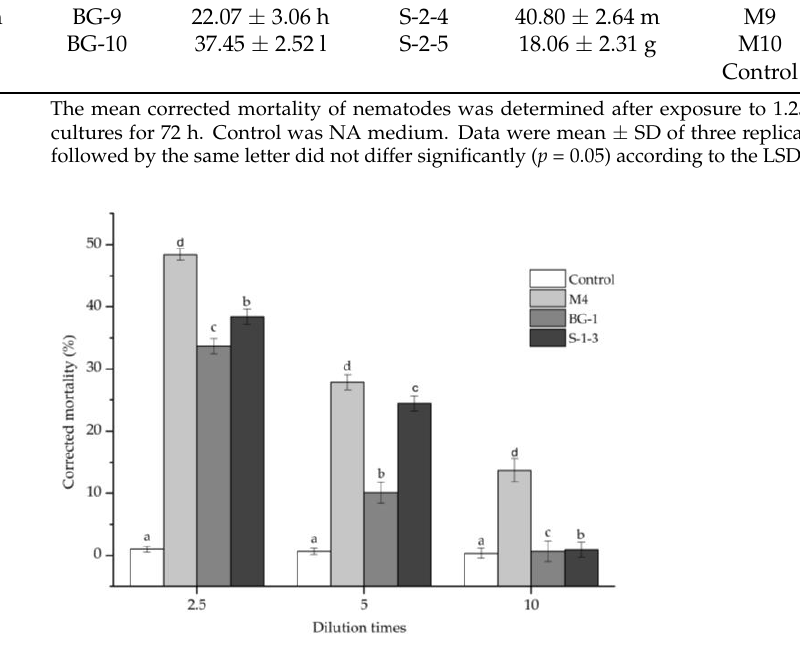
Figure 1. The nematicidal activity for the cell-free culture of strains M4, BG1, and S-1-3 diluted 10 times, 5 times, and 2.5 times, respectively. Data were given as mean. Means with the different letters were significantly different ( p < 0.05) based on one-way ANOVA with multiple comparison analysis using the LSD test.